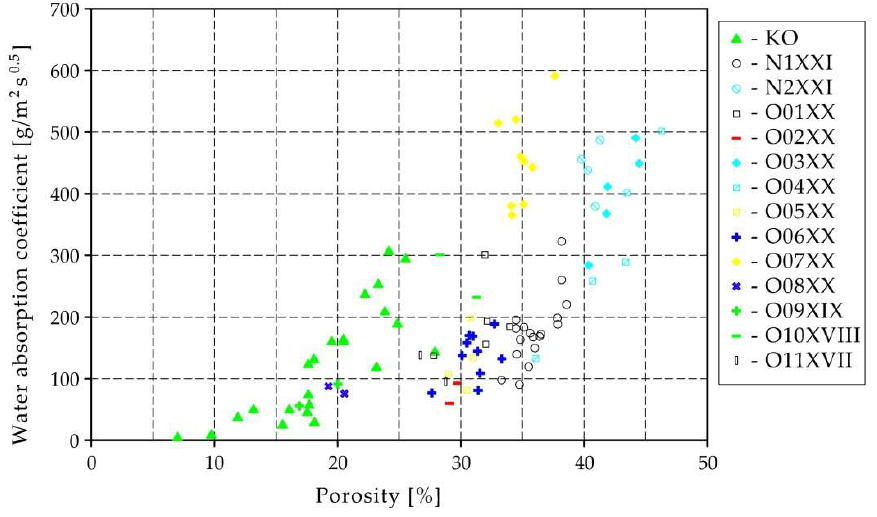
Figure 3. Relationship of water absorption coefficient and porosity.